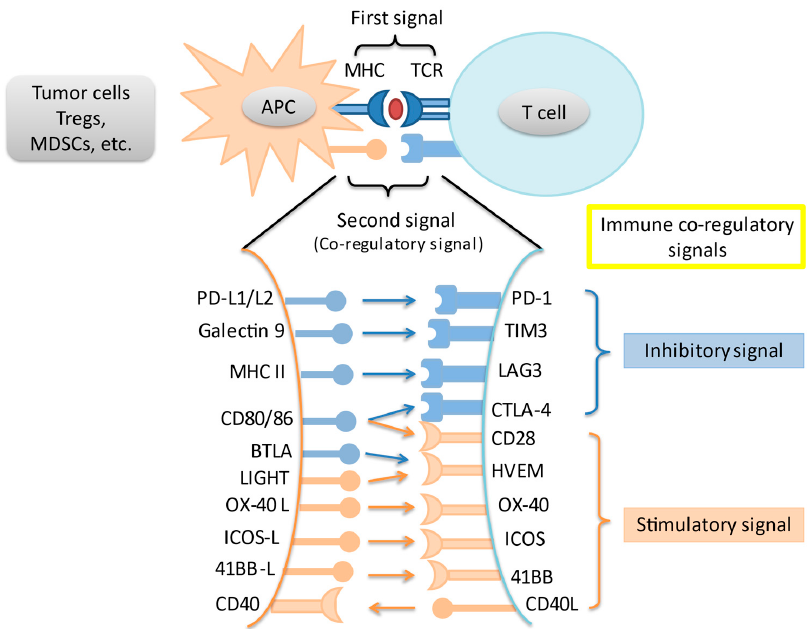
Figure 1. Interaction of main immune co-stimulatory/co-inhibitory molecules and their corresponding receptors. Cancer cells and other cells in the tumor microenvironment express a variety of inhibitory and stimulatory ligands that bind to their cognate receptors on immune cells, thereby leading to immune-modulation. These ligand-receptor pairs are known as immune checkpoints. Tregs = regulatory T cells; MDSC = myeloid-derived suppressor cell; APC = antigen presenting cell; TCR = T-cell receptor.